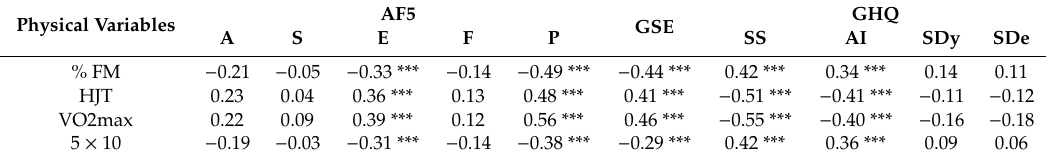
Table 5. Correlation analysis among physical fitness and psychosocial measures.